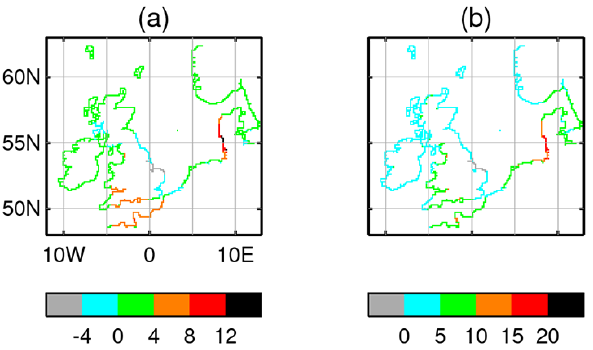
Figure 3. Projected contribution in centimetres of the change in storm surge climate to 21st century change in the 50-year return storm surge for (a) central estimate, (b) 95th percentile. Both are given in terms of the skew surge above astronomical high tide, and represent the contribution due to atmospheric storminess changes only.